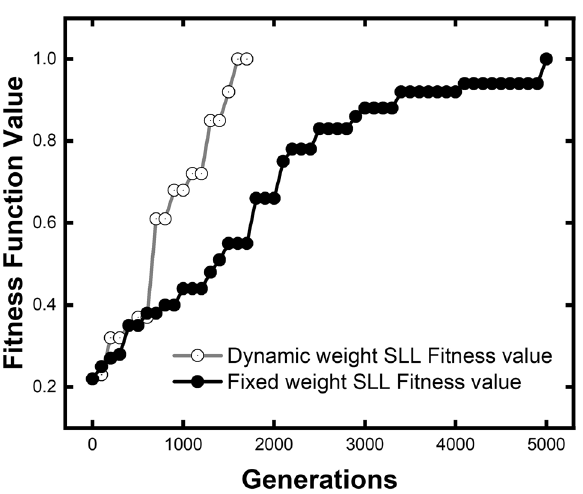
Figure 4. Comparison of SLL optimization efficiency between dynamic algorithm for fitness function and fixed weight fitness function. Dynamic algorithm has a significant advantage in SLL optimization efficiency at the early stage of GA